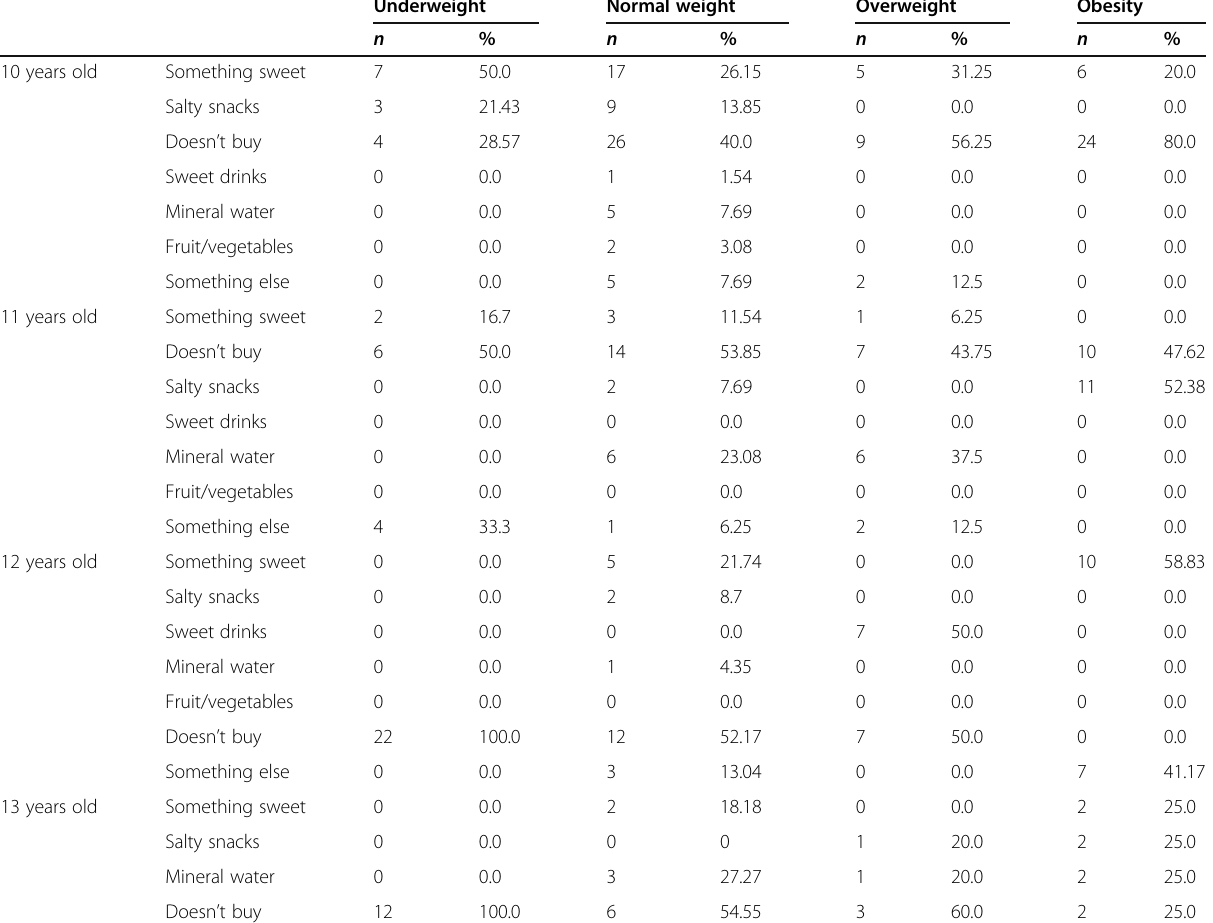
Table 10 The products bought in a school shop in a group of girls depending on age and BMI level (underweight, normal weight, overweight,